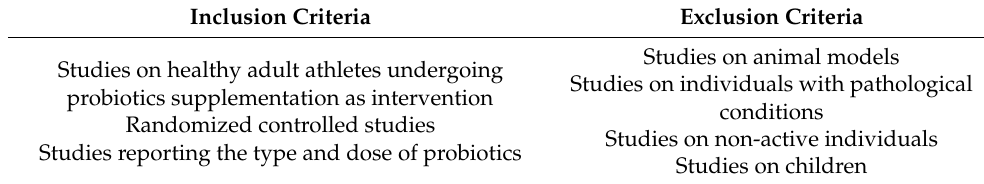
Table 1. Inclusion and exclusion criteria for the examined studies. Inclusion Criteria Exclusion